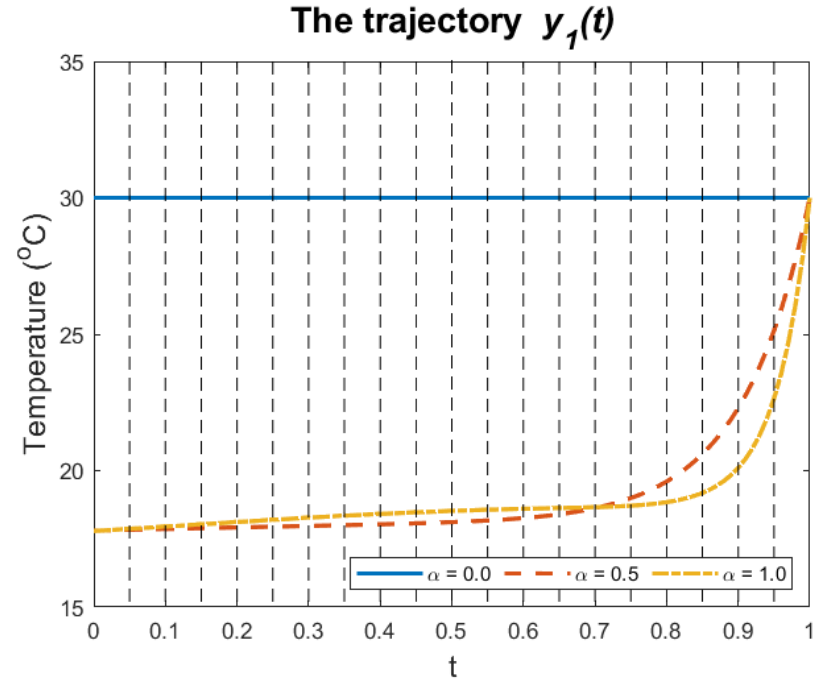
Figure 1. The trajectory of the state variable y 1 ( t )